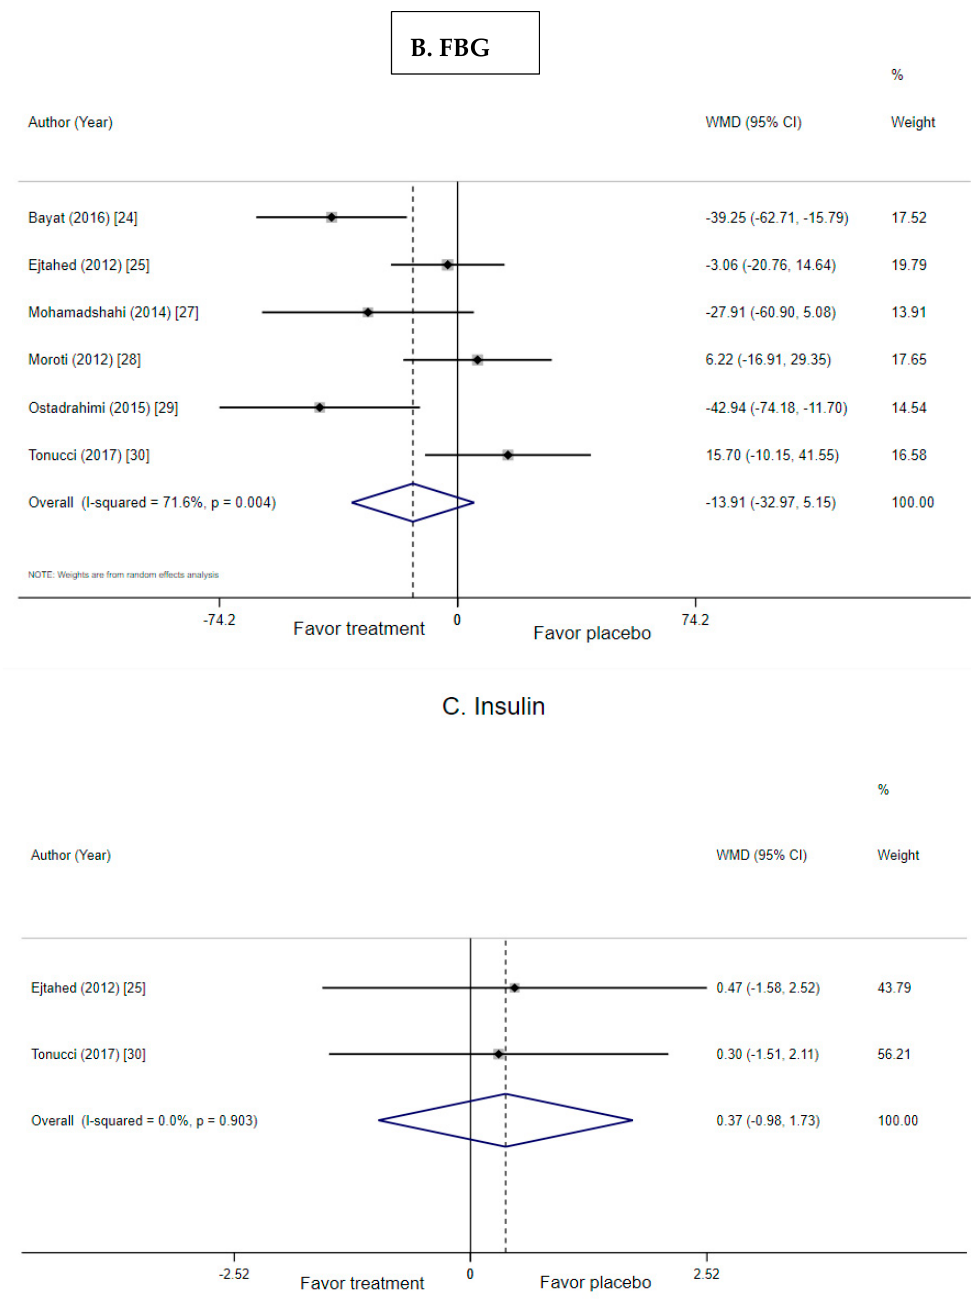
Figure 4. Forest plots for the effect of probiotic yogurt in T2D on ( A ) HbA1c, ( B ) FBG, and ( C ) insulin compared with the control in pooled analysis.